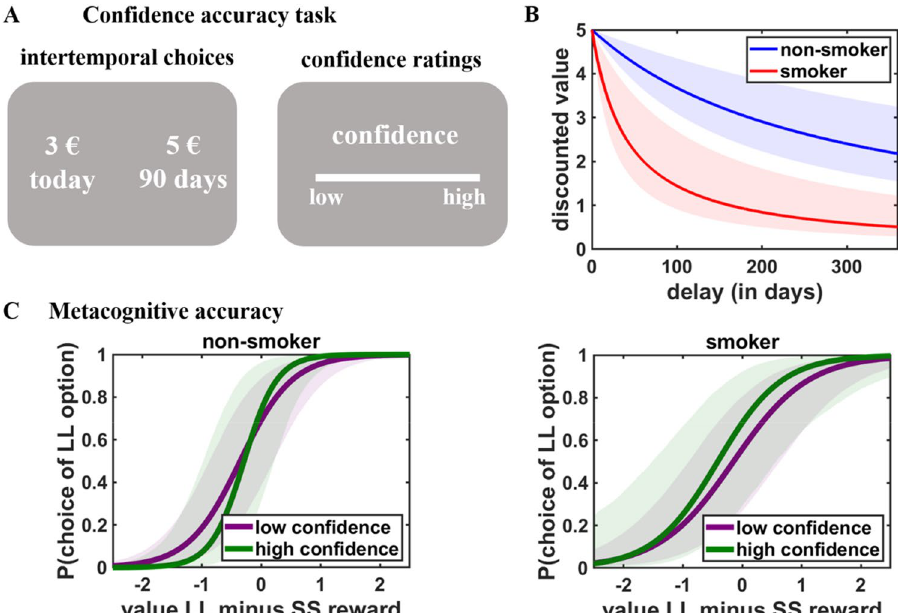
Figure 1. ( A ) In the confidence accuracy task, participants made choices between smaller-sooner (SS; e.g., 3 euro today) and larger-later (LL; e.g., 5 euro in 90 days) rewards. After each choice, they had to rate their subjective confidence to have made the best possible choice. ( B ) Consistent with previous findings, smokers discounted future rewards steeper than non-smokers. ( C ) Smokers also showed lower metacognitive accuracy than non-smokers, as indicated by a smaller difference between the slopes (which capture decision uncertainty) for low versus high confidence. For illustration purpose, we split confidence ratings into low versus high confidence trials. Shaded areas indicate 95% confidence intervals.